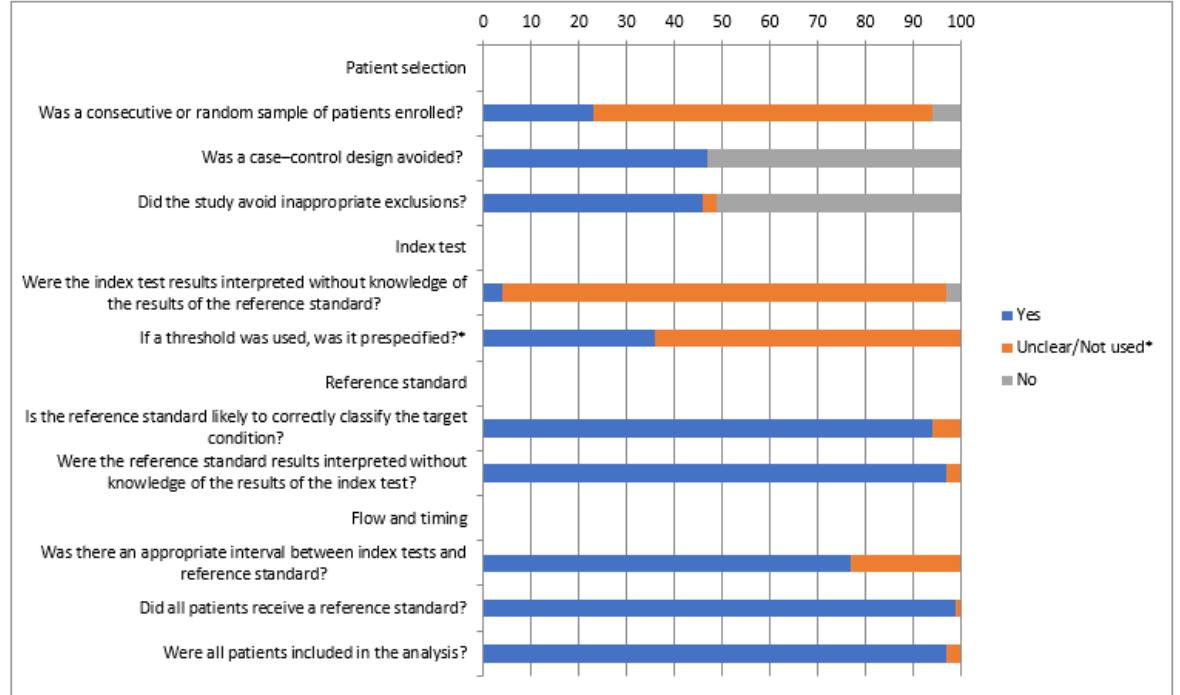
Figure 2. Summary of the quality of the studies included in this review. * means that in the question “if a threshold was used, as it prespecified?” .